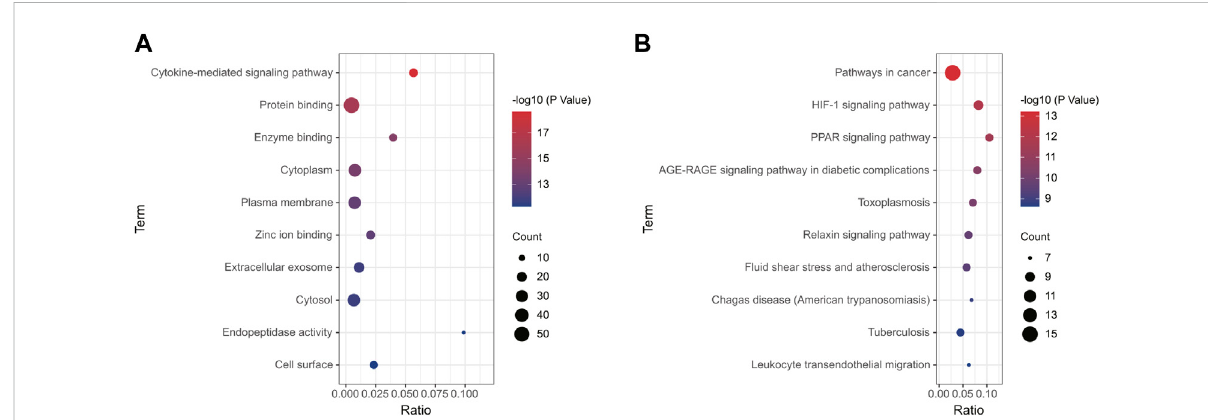
FIGURE 4 Enrichment analysis of all potential targets of 4-OI anti-sepsis. The GO and KEGG enrichment analysis of potential targets shows the enrichment data of the fi rst 10 GO and KEGG. (A,B) The circle size represents the number of genes involved, and the abscissa represents the frequency of the genes involved in the term total genes.